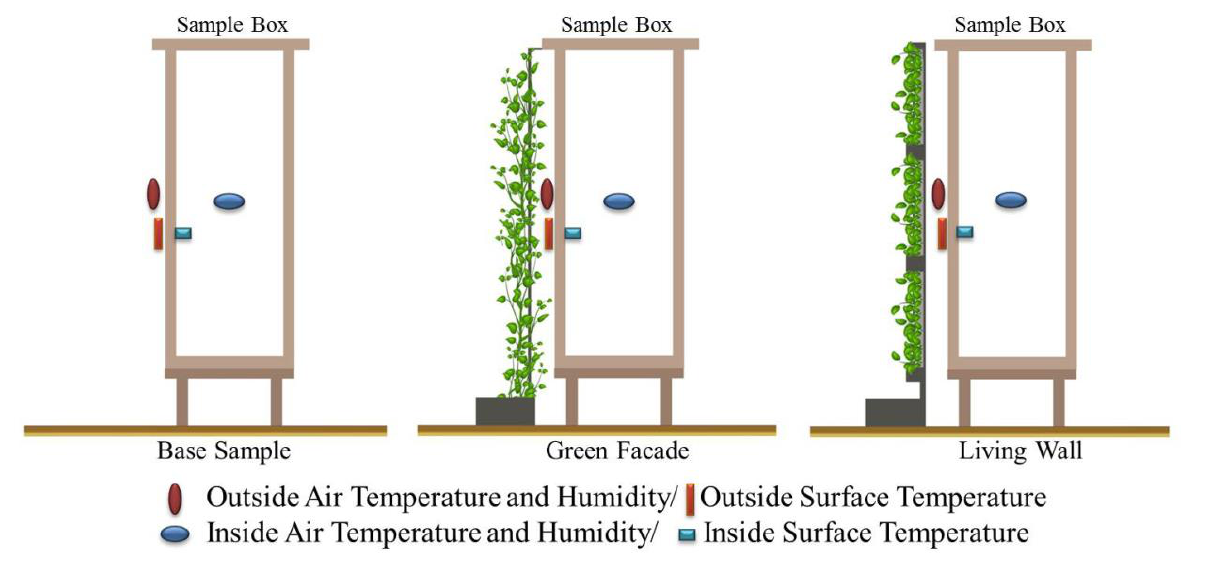
Fig. 3. Location of data loggers and hobos for bare facade (left), green facade (middle) and living wall